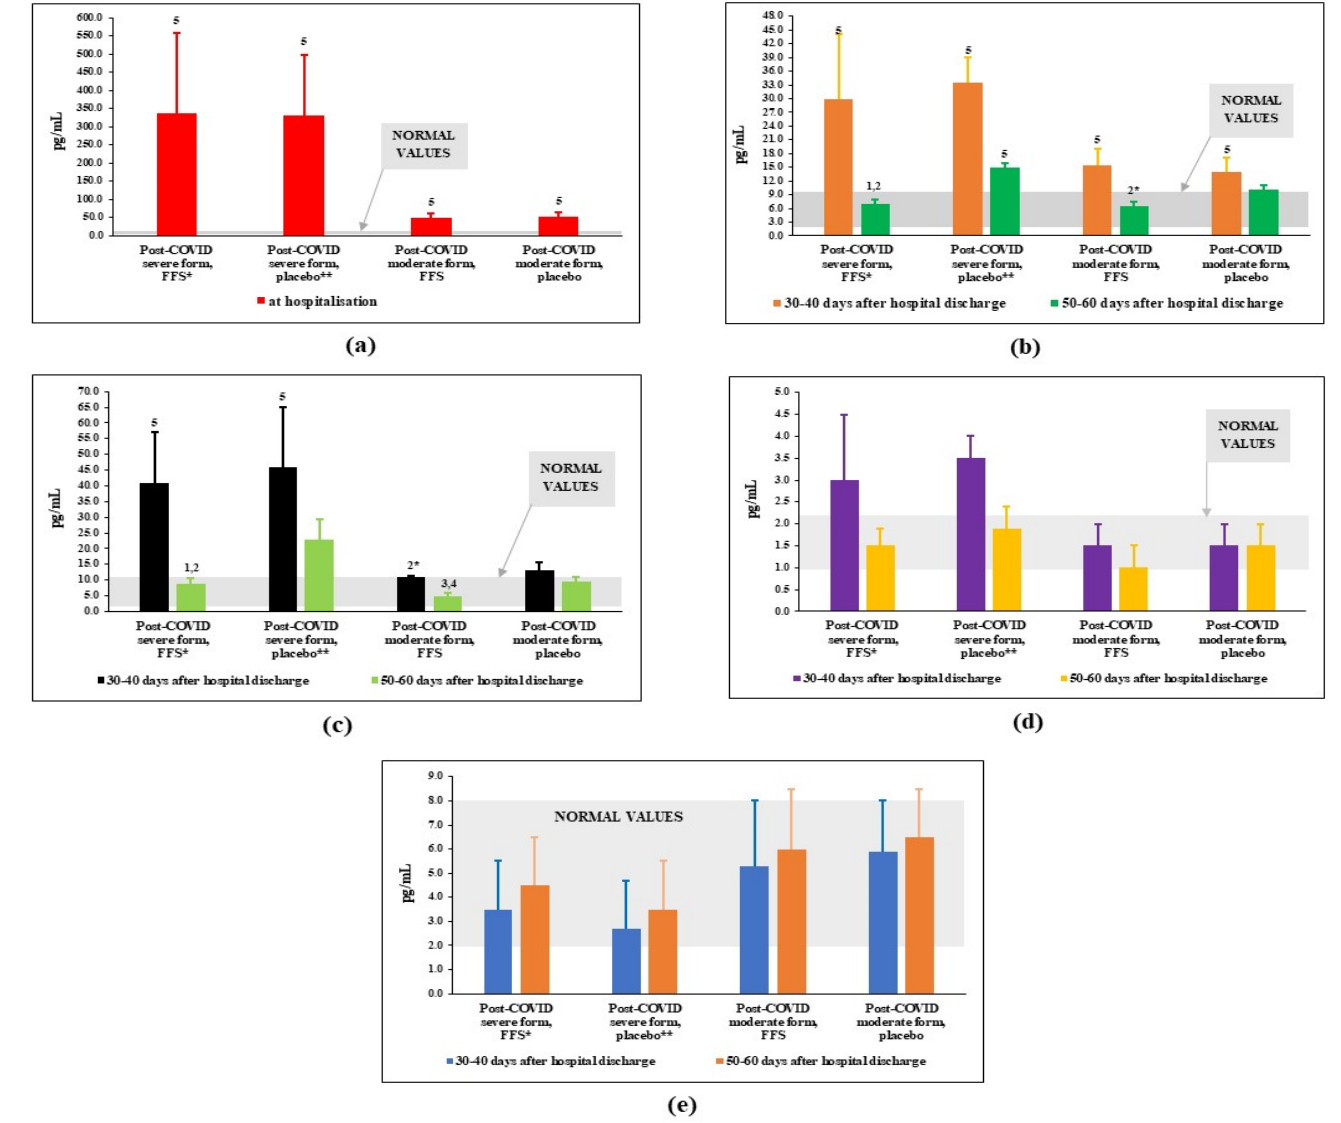
Figure 3. Plasma interleukin levels (pg/mL) in post-COVID period of the FFS and placebo groups. ( a ) IL-6 at the admission to the hospital; ( b ) IL-6 in the post-COVID period before and after supplementation with FFS or placebo; ( c ) IL-8 in the post-COVID period before and after supplementation with FFS or placebo; ( d ) IL-17A in the post-COVID period before and after supplementation with FFS or placebo; ( e ) INF- γ in the post-COVID period before and after supplementation with FFS or placebo.* FFS-Fermented fruit supplement, 28 g for 20 days; ** Placebo-diluted 5% honey 28 g for 20 days. Grey area covers normal range of values. 1 p < 0.01 vs. post-COVID severe form, FFS; 2 p < 0.01 vs. post-COVID severe form, 30–40 days after infection (before FFS); 2, *-0.05 < p < 0.1 vs. post-COVID severe form, FFS; 3 p < 0,01 vs. post-COVID moderate form, placebo; 4 p < 0.01 vs. post-COVID moderate form, 30–40 days after infection (before FFS); 5 p < 0.01 vs. donors.